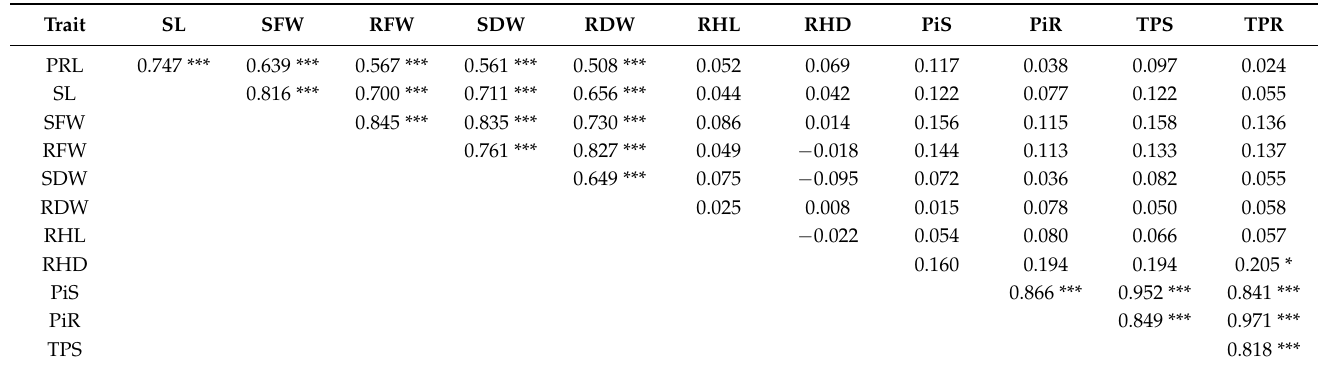
Table 3. Pearson’s correlation coefficients among agro-morphological and P-content-related traits in 100 finger millet F 2:3 RILs under HP